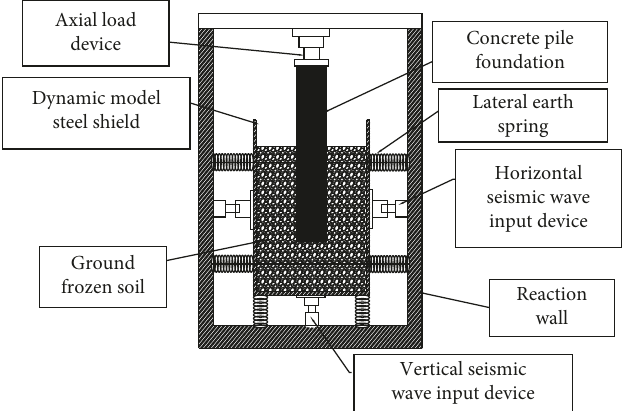
Figure 1: Frozen soil pile foundation model.